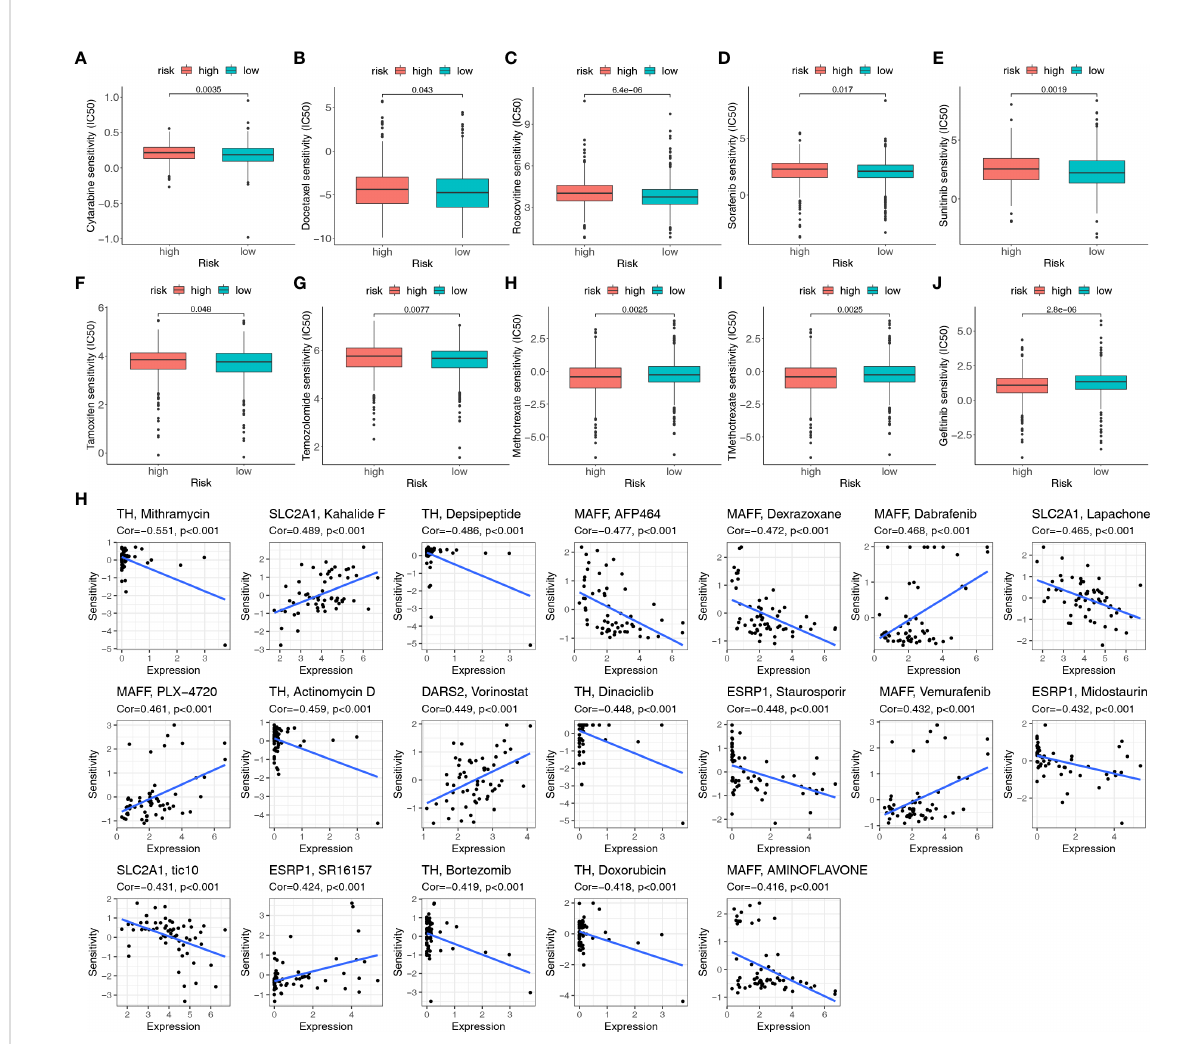
FIGURE 9 The sensitivity of chemotherapeutic agents and the prediction of potential drugs. (A – J) Comparison of the IC50 values of chemotherapy and targeted agents in the two risk groups, including cytarabine, docetaxel, sorafenib, temozolomide, tamoxifen, roscovitine, sunitinib, ge fi tinib, methotrexate, and TMethotrexate. (H) Sensitivity correlation analyses of the HLMRGs and potential drugs according to the CellMiner